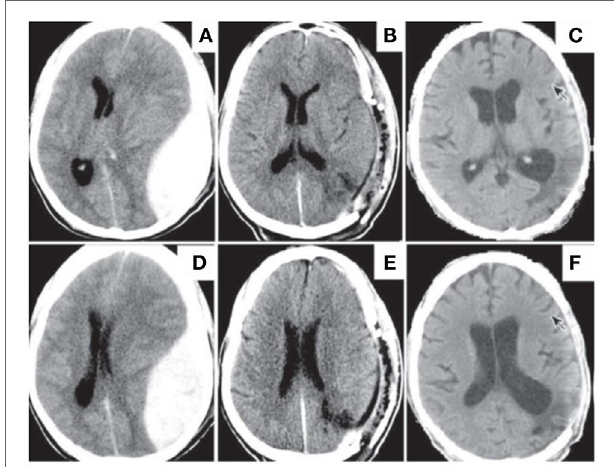
FiGURe 1 | Traumatic head injury resulting in development of vS with subsequent bilateral cortical atrophy . Patient was admitted with extradural hematoma (A,D) . Evacuation of hematoma relieved brain asymmetry (B,e) . However, patient decompensated to a VS with delayed cerebral atrophy observed at 4 months post-op. Note enlarged sulci, particularly in the fronto-temporal lobes (C,F) . Reproduced from Louzada et al. (65) with